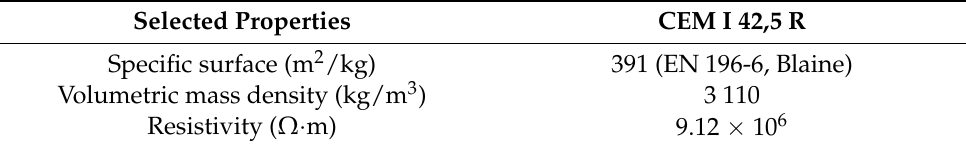
Table 1. Properties of the CEM I 42,5 R cement.